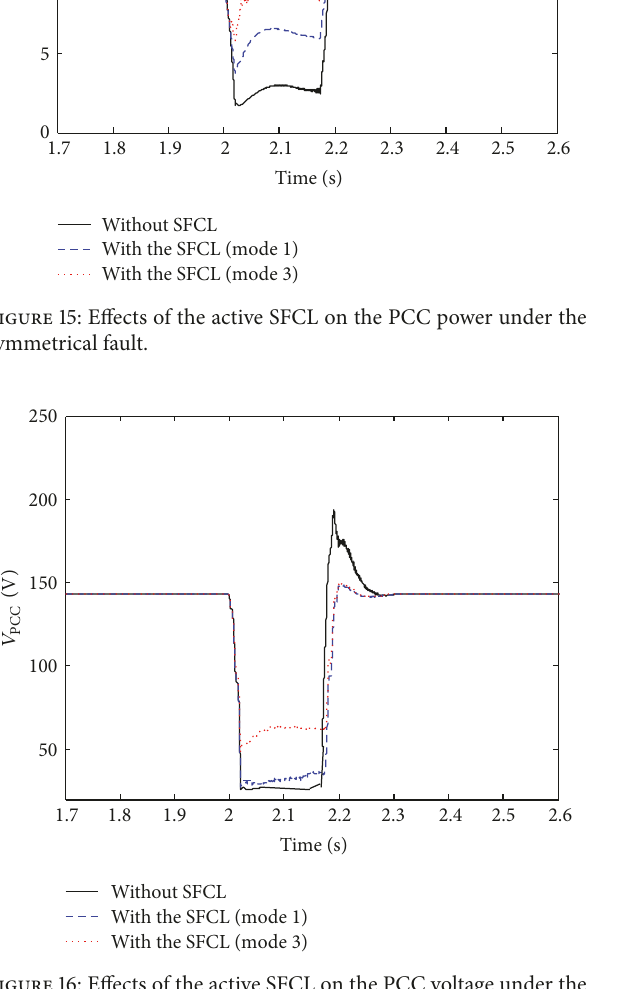
Figure 16: Effects of the active SFCL on the PCC voltage under the symmetrical fault.